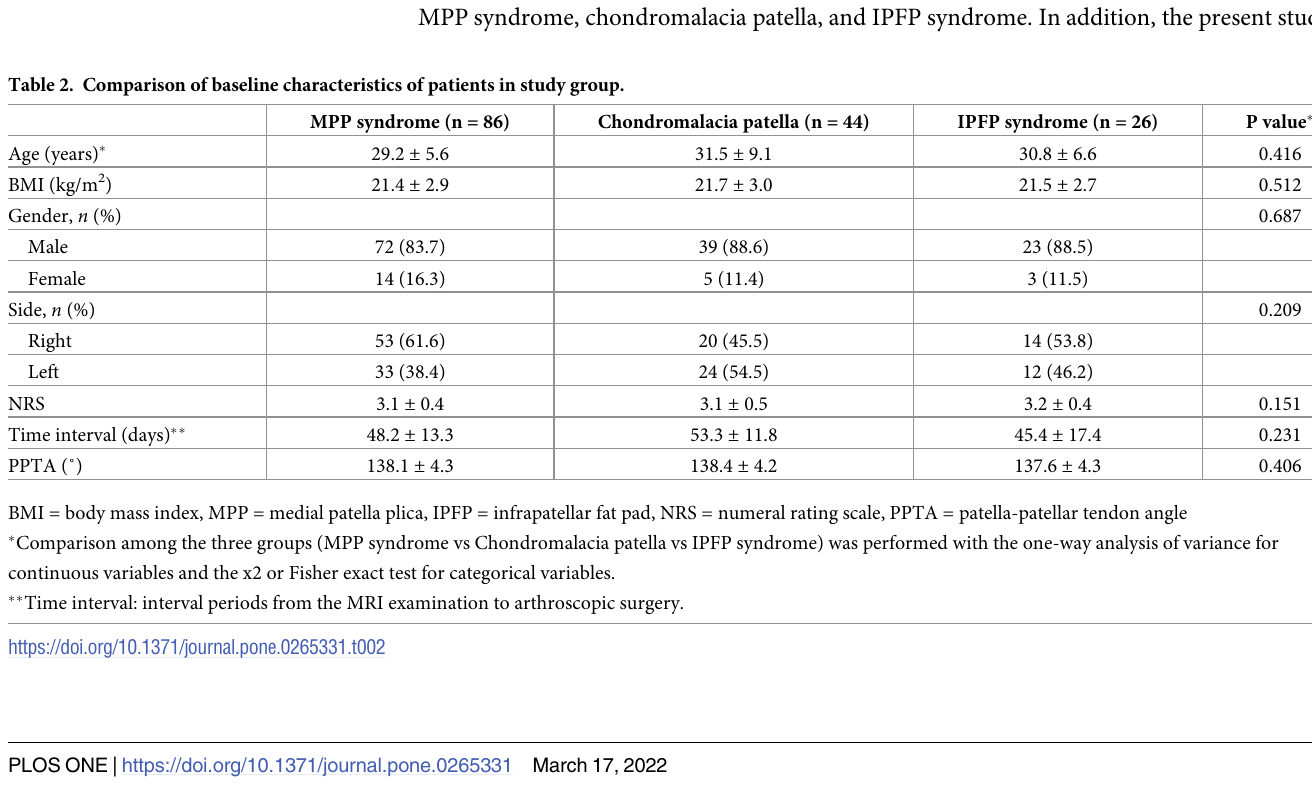
Table 2. Comparison of baseline characteristics of patients in study group.